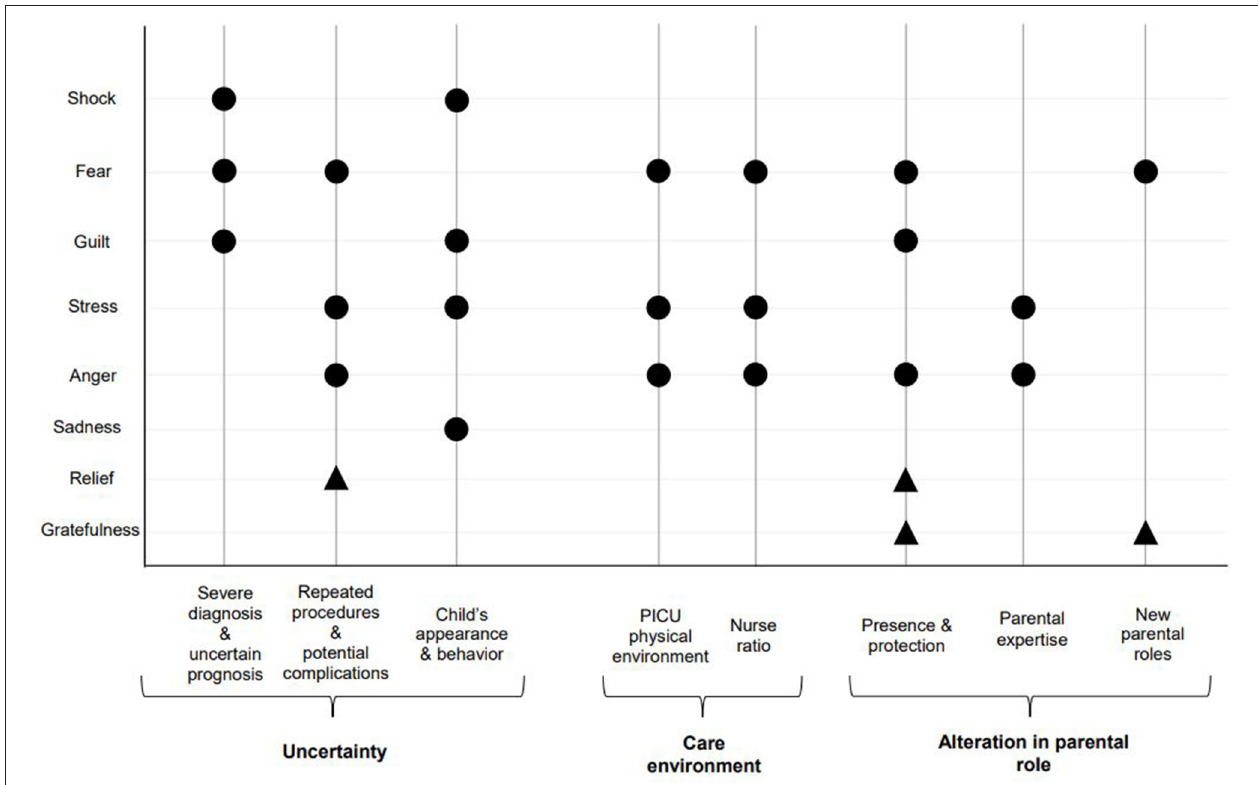
FIGURE 3 | Families-reported emotions in response to PICU-related sources of stress, throughout the PICU stay. • : Negative emotions N : Positive